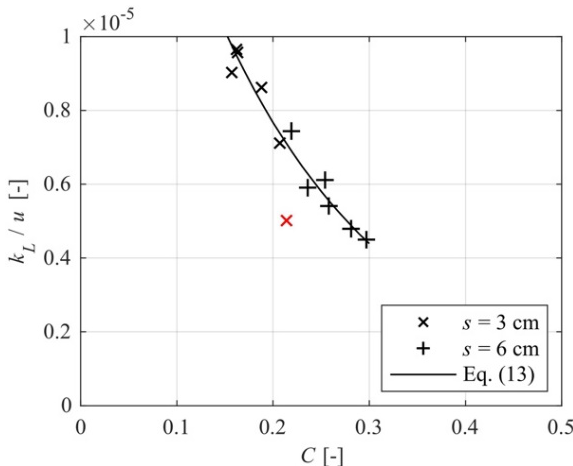
Figure 6. Relative mass transfer velocity k L / u as a function of the mean air concentration (the red marker results from the configuration with 1:2 slope, s = 3 cm step height and q = 0.07 m 2 /s discharge and has been neglected for the curve fitting).